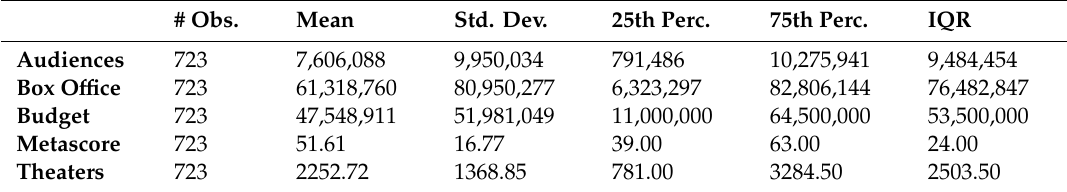
Table 1. Summary Statistics during Years 2010–2015.